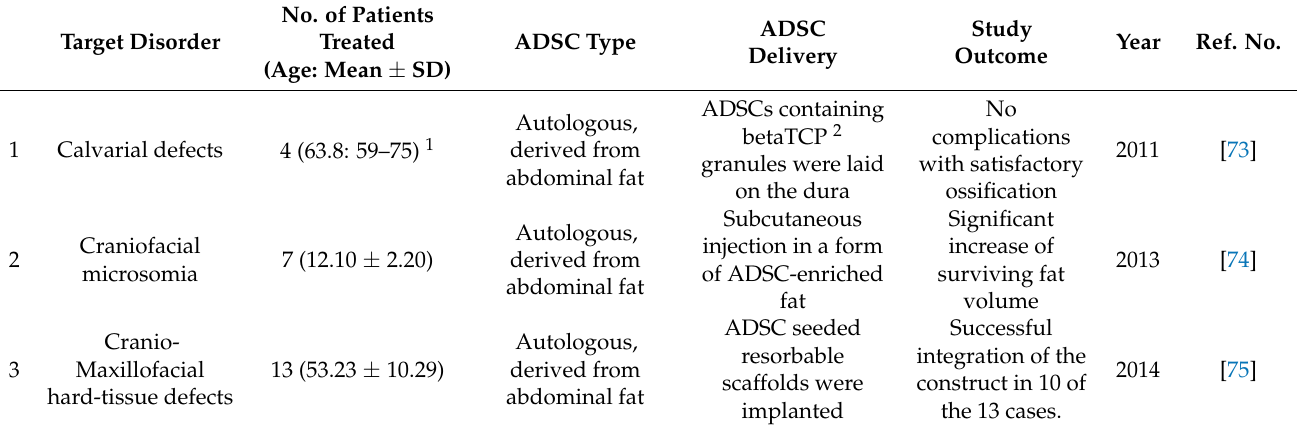
Table 2. Summary of clinical studies involving the use of isolated hADSCs on craniomaxillofacial defects for the last 10